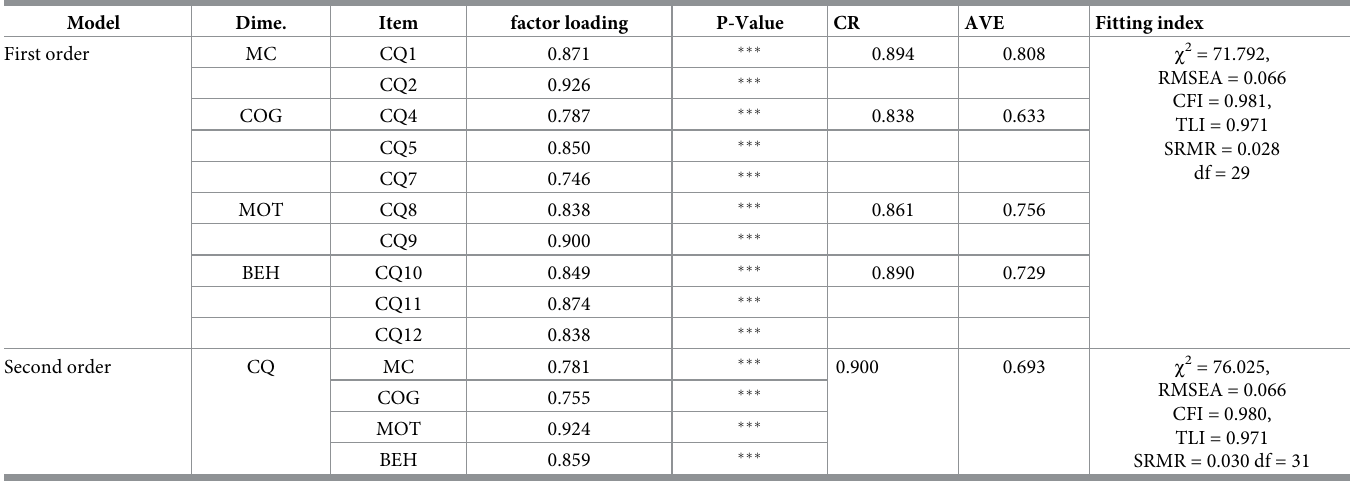
Note: MC, COG, MOT, BEH represent the four dimensions of CQ respectively. MC = Metacognition, COG = Cognition, MOT = Motivation, BEH = Behaviour. ��� p <